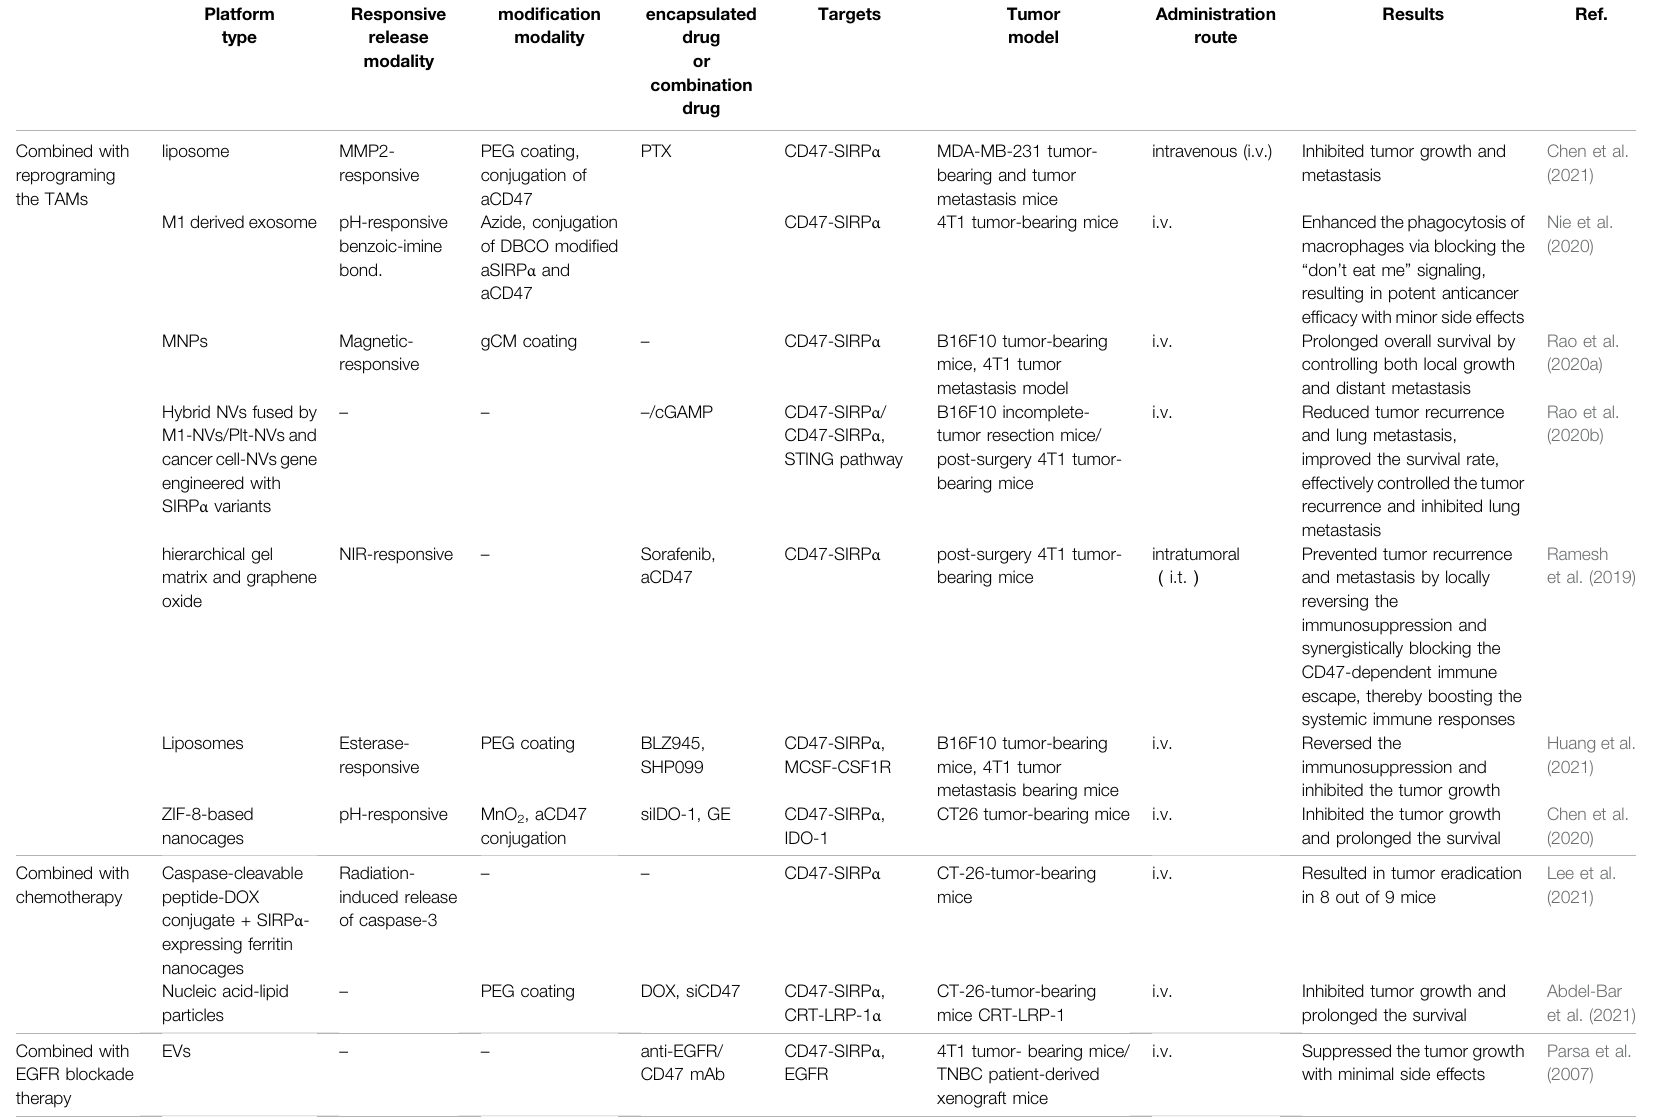
TABLE 3 | Examples of nanoparticle-based combination therapy utilized blocking CD47-SIRP α signal